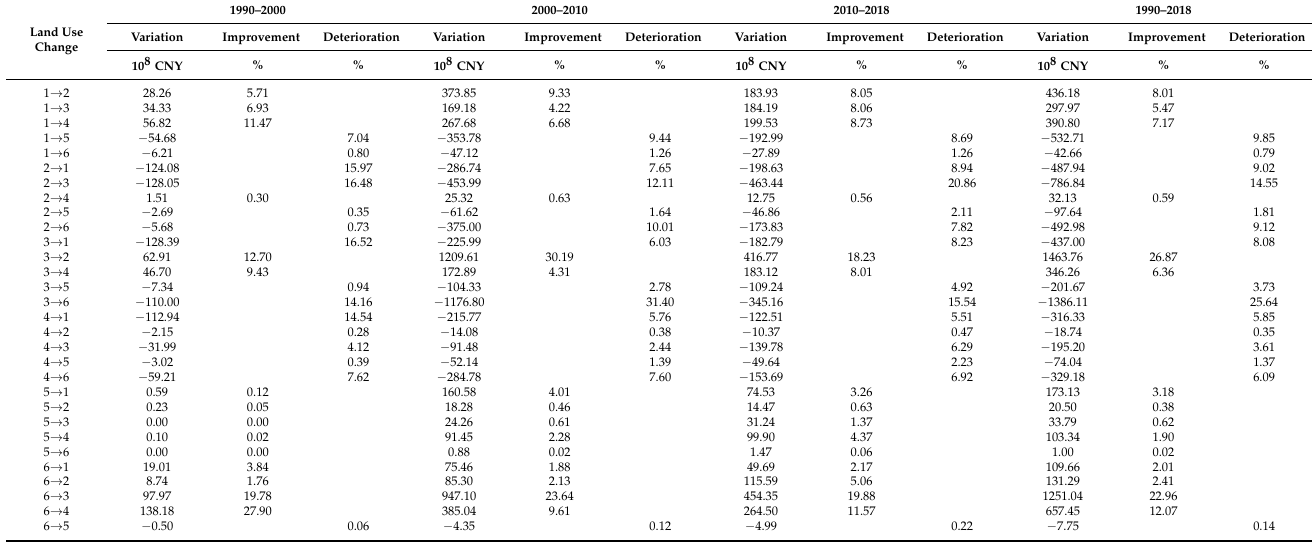
Table 4. Contribution rate of land use change to ESV in the YRB during